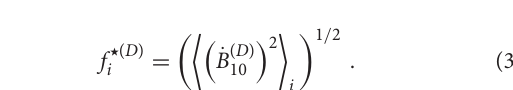
Frontiers in Earth Science |